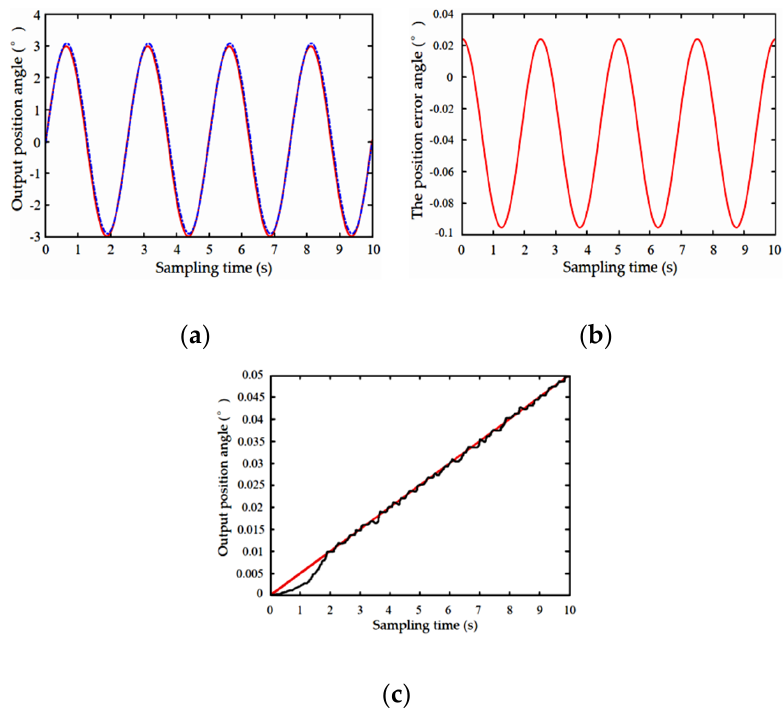
Figure 9. PID control result. ( a ) Sin position output for PID control, ( b )Position error, ( c ) PID control angle position output.